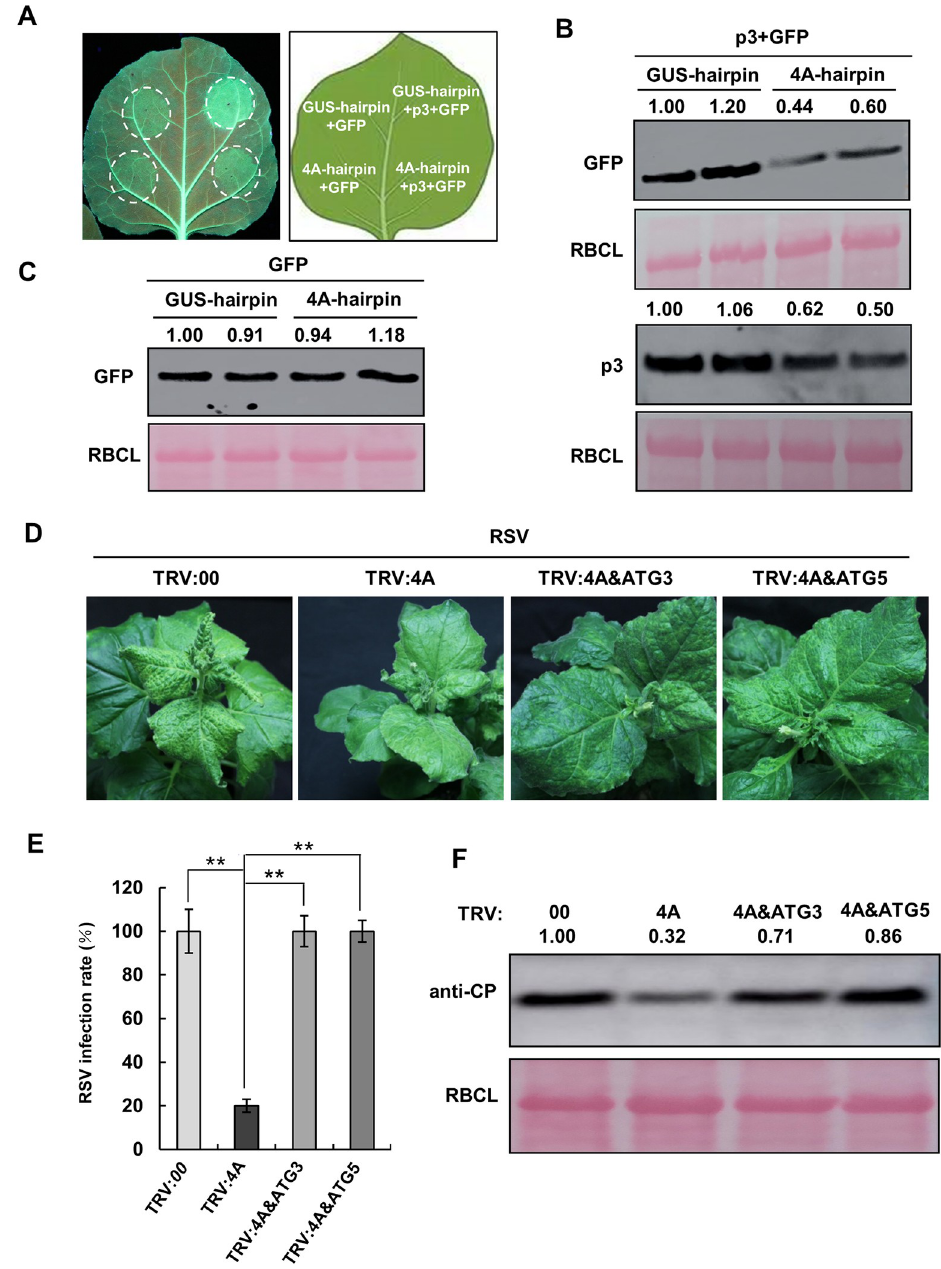
Fig 3. Inhibition of RSV Infection in Nb eIF4A -Silenced Plants Requires Activated Autophagy. (A) RNAi constructs expressing hairpin RNA of Nb eIF4A (4A-hairpin) and expressing hairpin RNA of β -glucuronidase (GUS- hairpin) were transiently expressed individually in one leaf of 16c plants for 1 day. p3 and (or) GFP were then expressed for additional 3 days. Green fluorescence was detected under UV. (B) Immunoblot analysis of protein expression probed with anti-p3 or anti-GFP antibody. Rubisco large subunit was used as a loading control. (C) Immunoblot analysis of GFP in a control experiment probed with anti-GFP antibody. (D) Development of RSV symptoms in co-silenced plants (TRV:4A&ATG3 and TRV:4A&ATG5), control plants (TRV:00), and Nb eIF4A- silenced plants (TRV:4A). (E) RSV infection rates in different plants. Error bars indicate standard error from three individual experiments. Twenty plants were used for each experiment. (F) Immunoblot analysis of RSV CP accumulation levels in the infected plants with anti-CP antibody. Band intensity was analyzed by ImageJ.